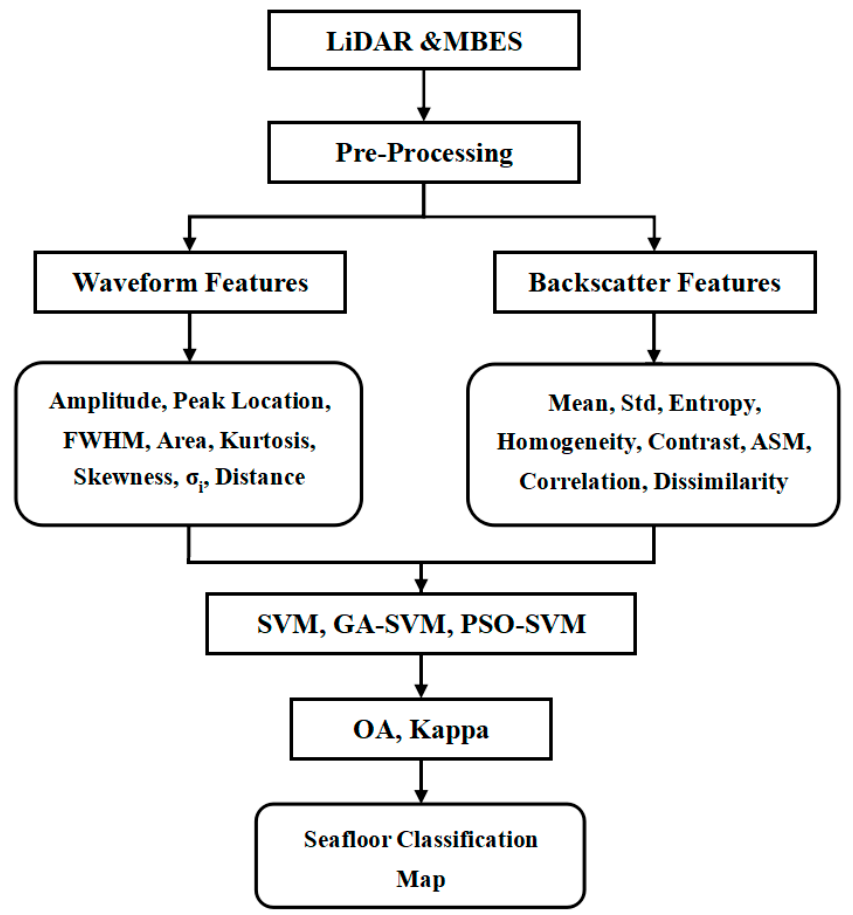
Figure 2. Framework of the proposed classification methods.